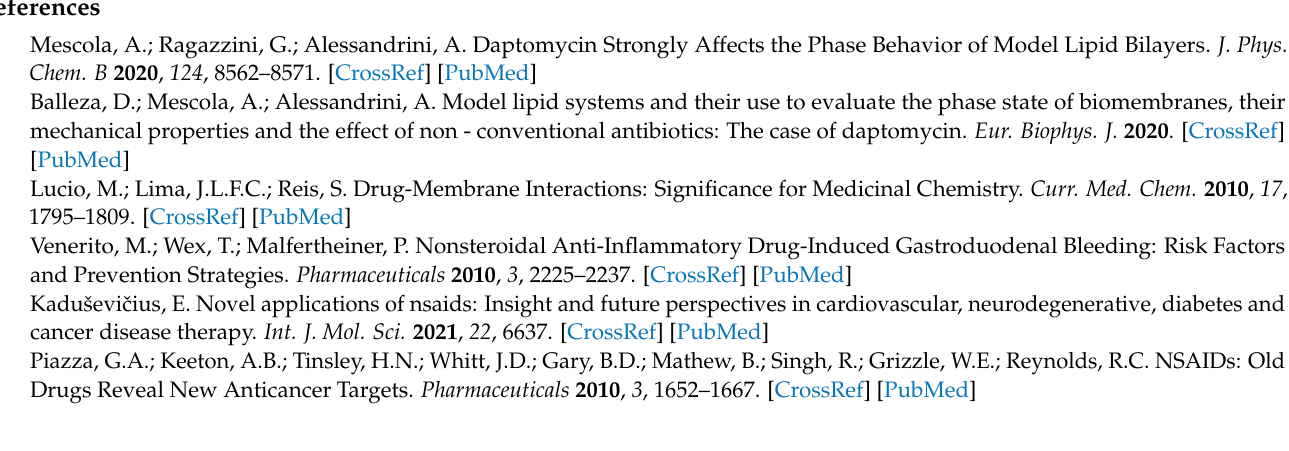
Table S3: Toxicity of oxicam